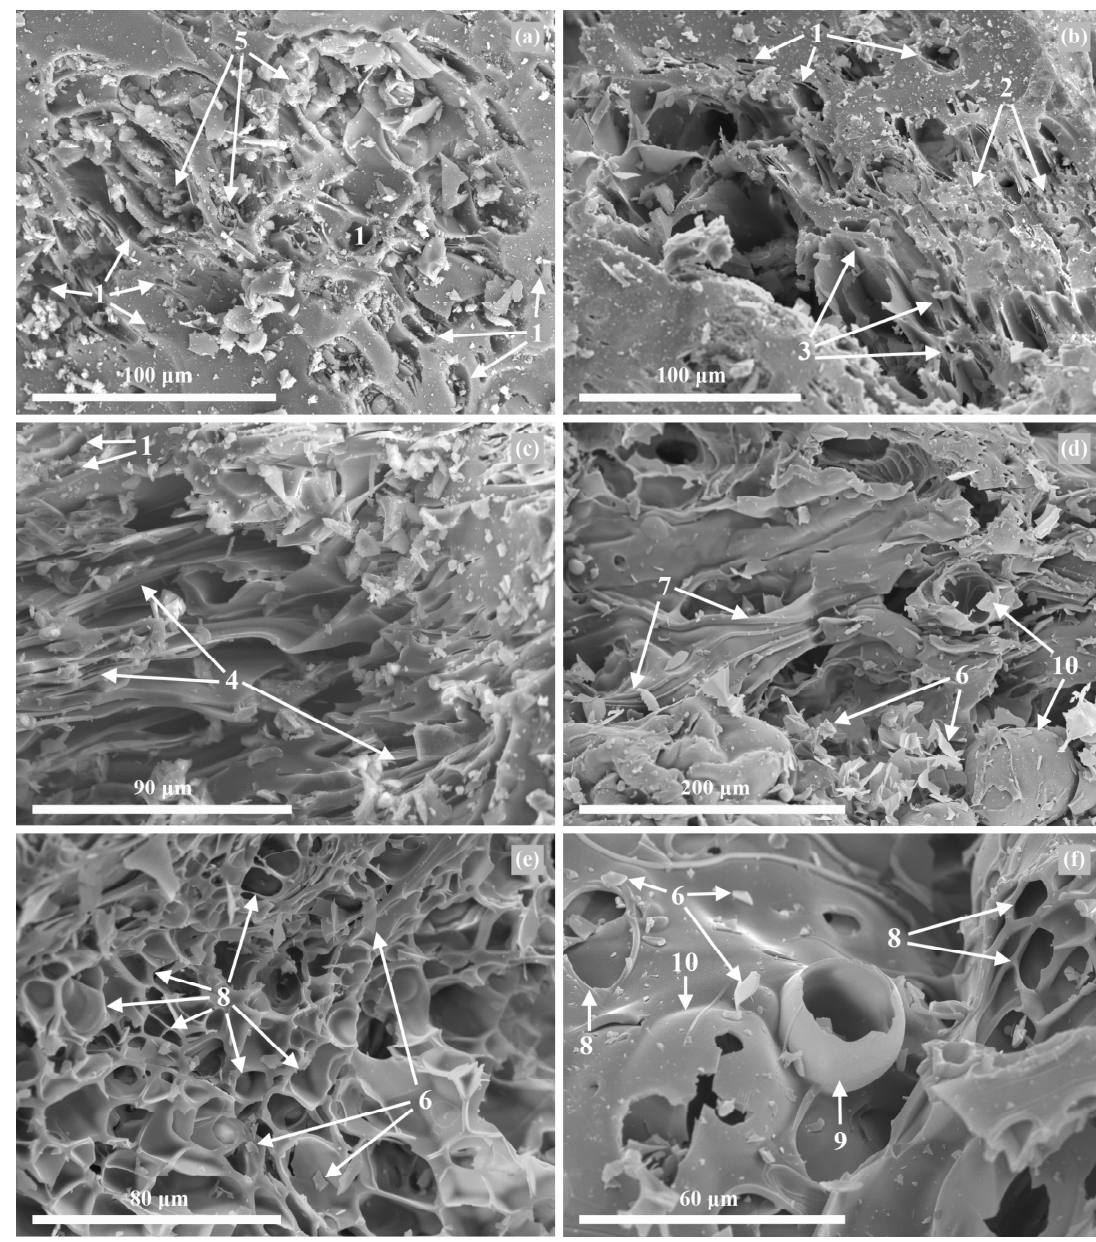
Figure 2. Secondary electron images of 1.18–2.5 mm industrial size fraction of Tsigrado perlite sample: ( a – c ) crude perlite and ( d – f ) its expanded counterpart. 1: voids; 2: pumiceous microstructure; 3: elongated vesicles; 4: pockets of coalesced vesicles; 5: crystalline patches; 6: expanded perlite sherds; 7: open pores; 8: closed pores; 9: thin-walled bubbles; and 10: microspheres.